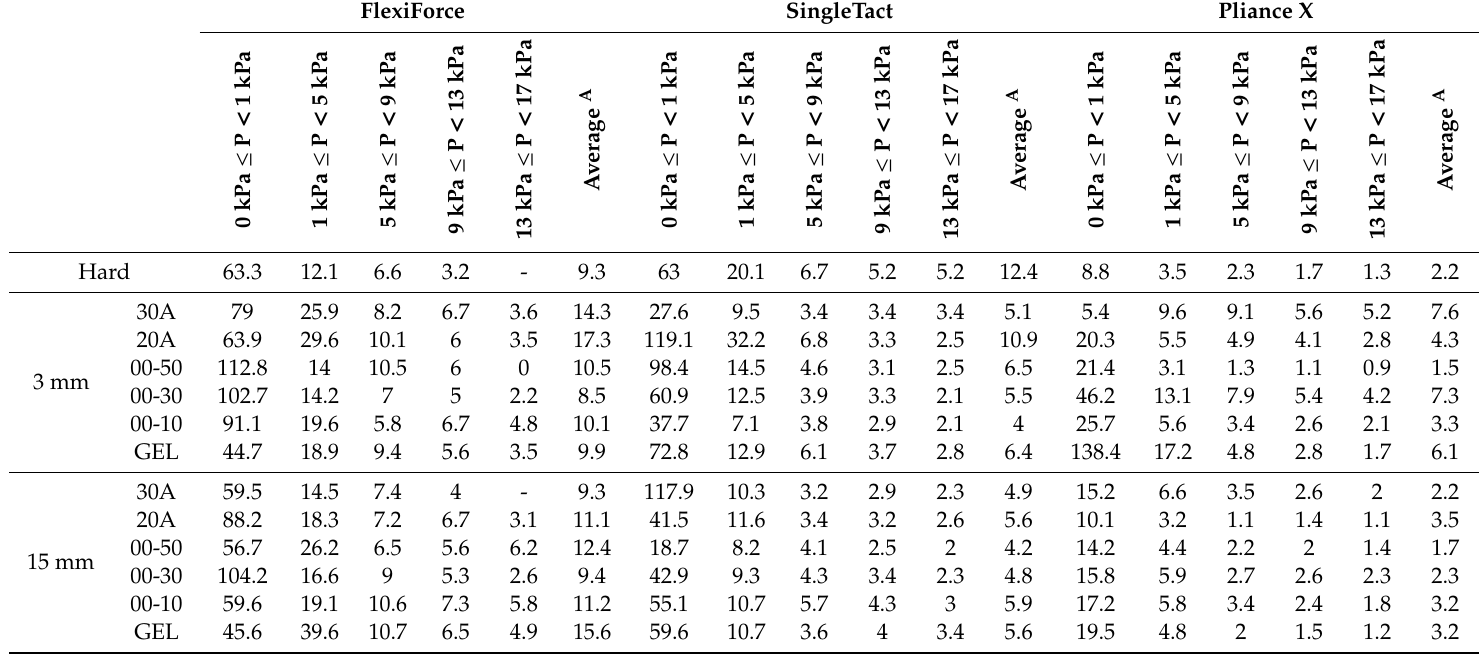
Table 6. Repeatability of di ff erent sensors measured on surfaces with di ff erent hardness. (Coe ffi cient of variation for repeated measurements of sensor